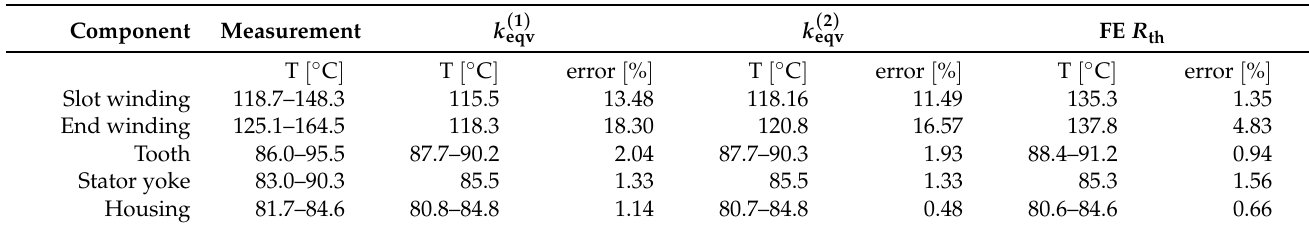
Table 2. Comparison of